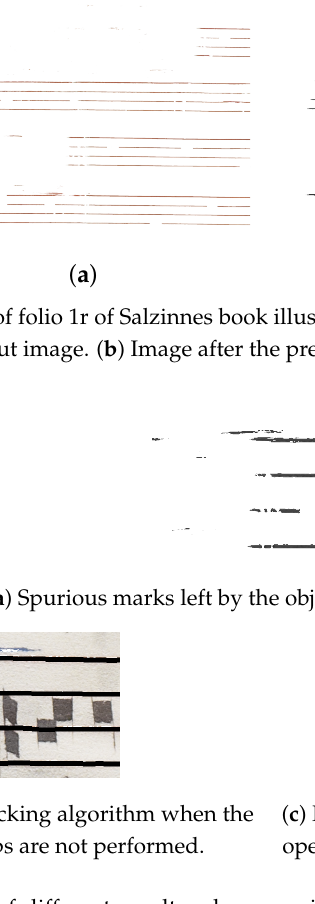
Figure 4. Illustration of different results when opening and closing pre-processing steps are not applied or applied before the staff tracking algorithm (described in Section 3.3). Detail of folio 52r of Salzinnes